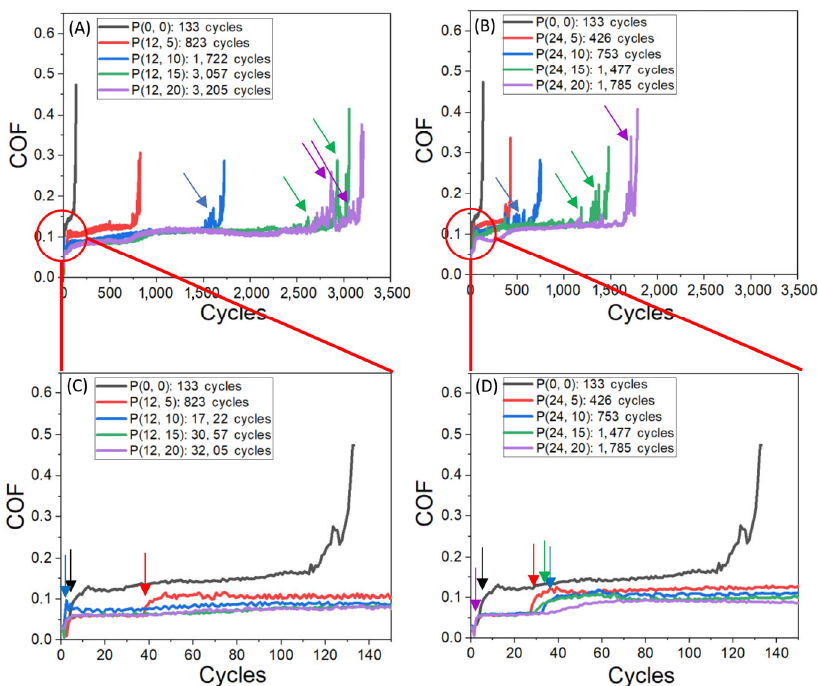
Fig. 8 COF of the PDA/PTFE coatings on smooth and laser textured stainless steel substrates during the durability tests: Texture path segment length of (A) 12 μ m, (B) 24 μ m, (C) and (D) zoom-in plots of the first 150 cycles of (A) and (B),